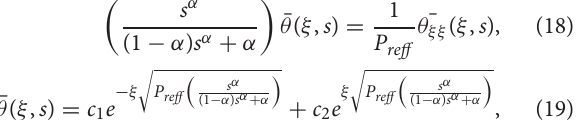
FIGURE 4 | Velocity profiles with altered values of k p and other parameters are G r